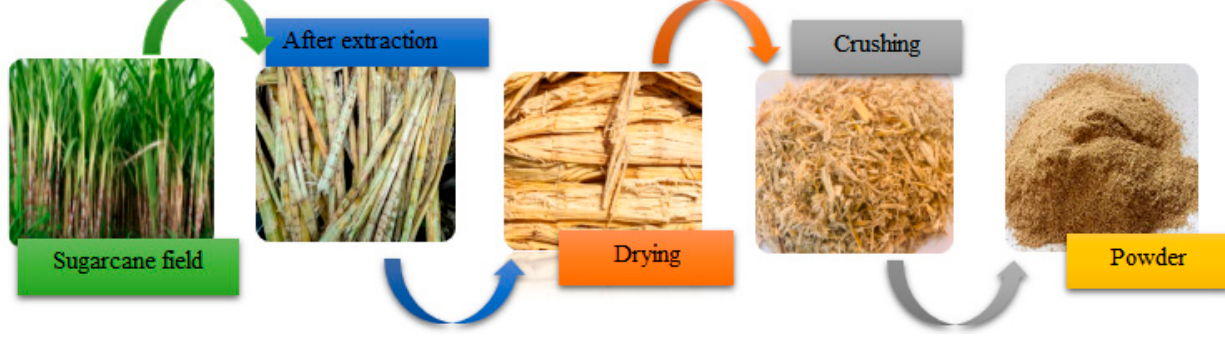
Figure 1. Sugarcane bagasse material steps.